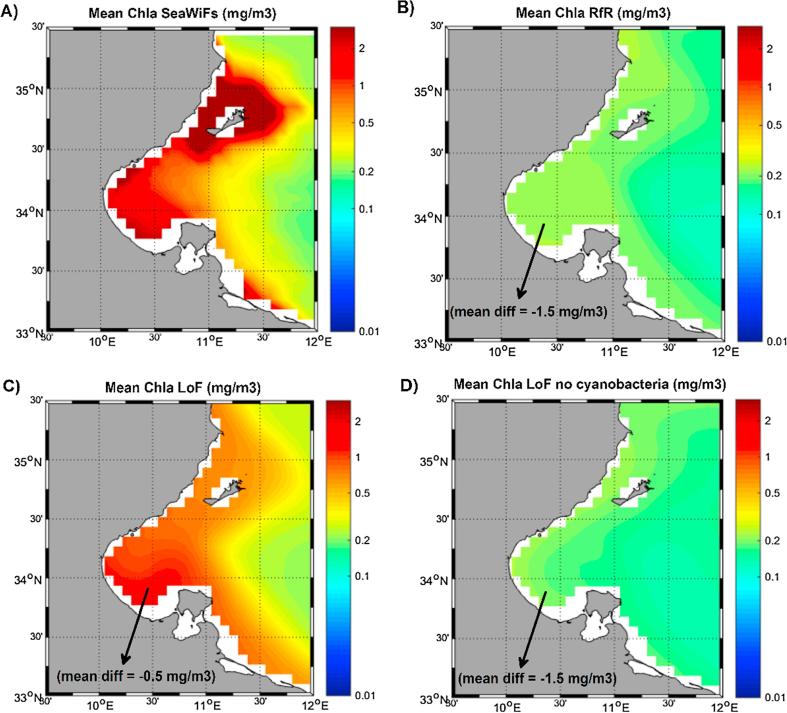
(A) Climatological (2001–2004) surface chlorophyll from SeaWiFs (mg/m3). (B) Climatological (2001–2007) surface chlorophyll from RfR run (mg/m3). (C) Climatological (2001–2007) surface chlorophyll from LoF run (mg/m3). (D) Climatological (2001–2007) surface chlorophyll from LoF run eliminating the cyanobacteria group (mg/m3).